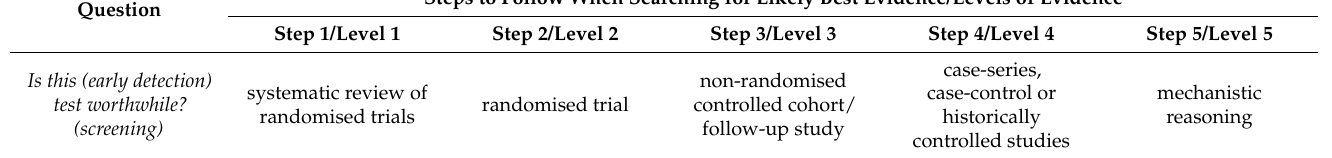
Table A4. Steps of likely best evidence searching for screening studies and levels of evidence. From the Oxford Centre of Evidence-Based Medicine Levels of Evidence